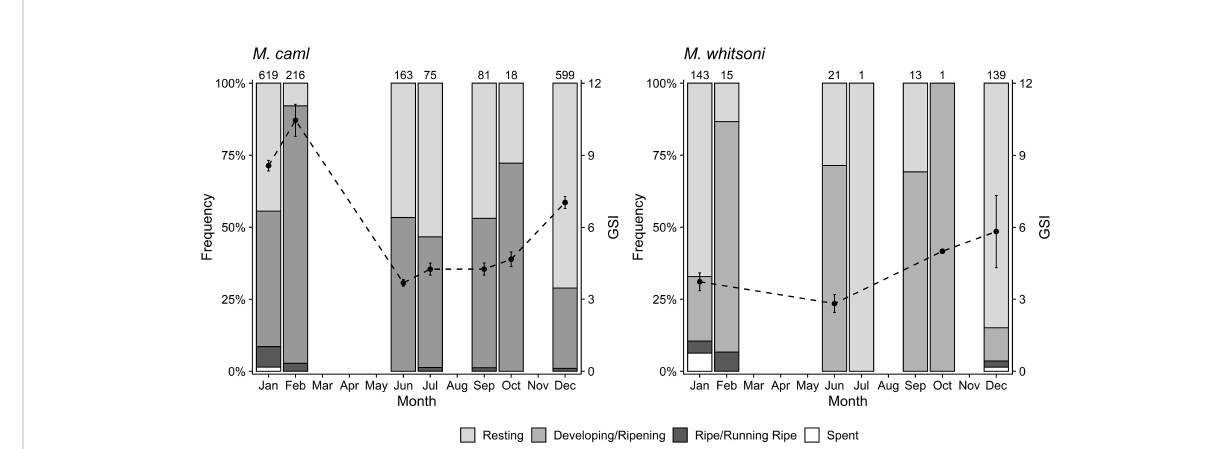
FIGURE 9 The percentage of females with gonads at stages 2 – 5 and mean monthly gonadosomatic indices (GSI ± standard error) of gonads in stages 3 – 5 for Macrourus caml (left) and M. whitsoni (right) in the Ross Sea region. Numbers above sampling bins represent sample sizes for staging data in each